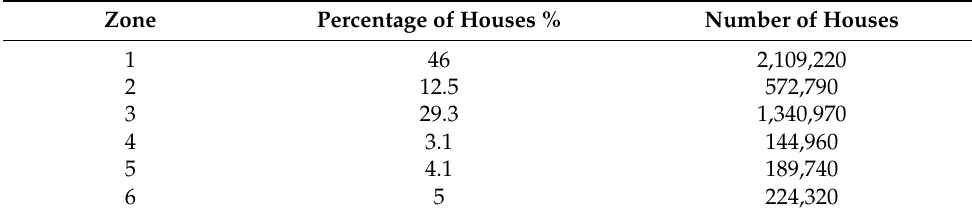
Table 7. Distribution of occupied houses per climatic zone in Morocco. Zone Percentage of Houses % Number of Houses 1 46 2,109,220 2 12.5 572,790 3 29.3 1,340,970 3.1 144,960 5 4.1 189,740 5